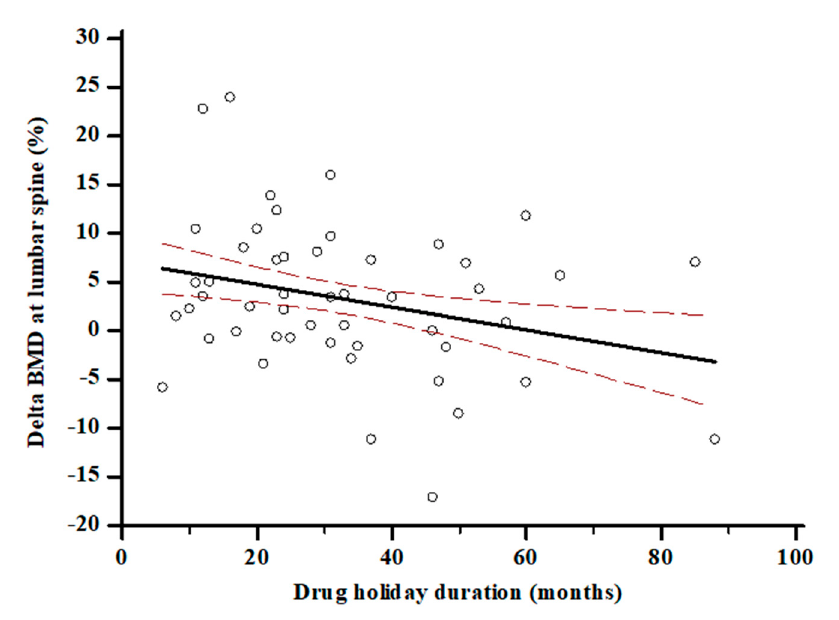
Figure 2. Association between ALN discontinuation—i.e., drug holiday—and BMD change at lumbar spine. (r = − 0.27; p = 0.005).